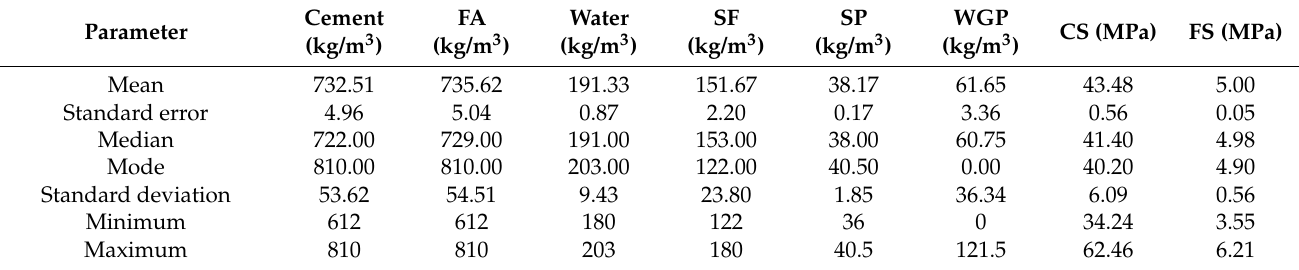
Table 1. Descriptive statistical analysis of input and output